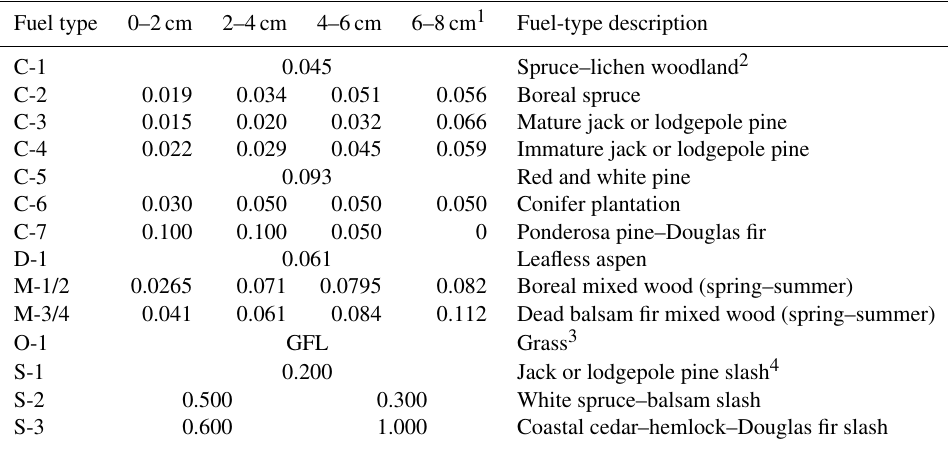
Table 1. FBP fuel types and bulk densities (gcm − 3 ) of surface fuels for each fuel